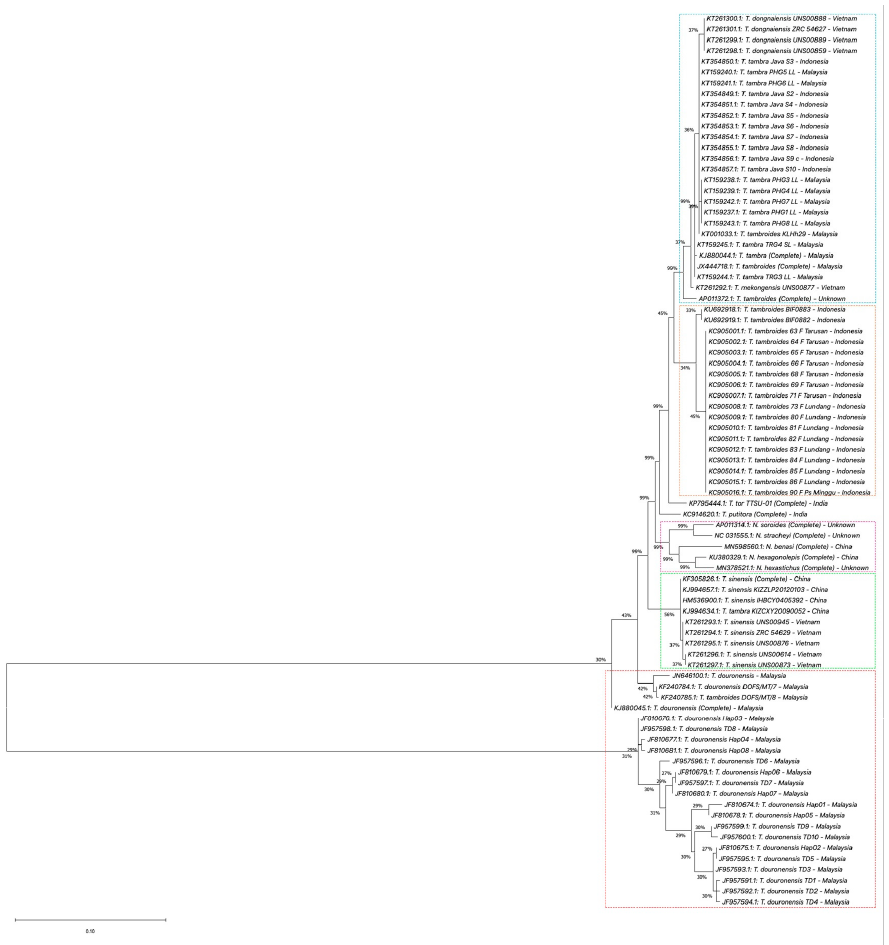
Figure 4. Phylogenetic tree of Tor species using the COX1 gene. The evolutionary history of the listed Tor species was inferred by using the maximum likelihood method and Tamura–Nei model [126]. These analyses were conducted using MEGA X (Version 10.1) [114,115]. Percentages on the branches represent bootstrap values.